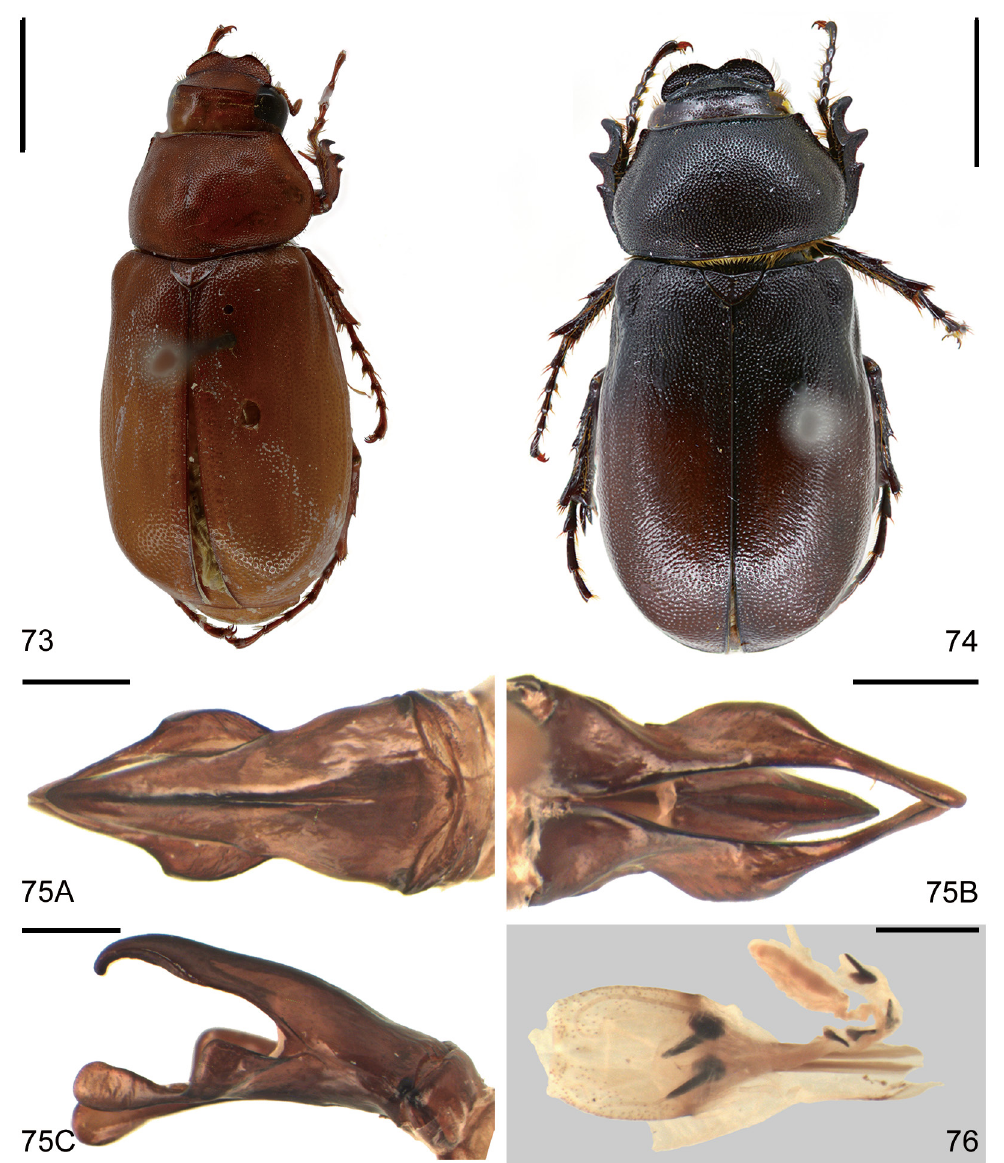
Figs 73–76. 73 . Miridiba behrensi Brenske, 1892, lectotype, ♂ (MFNB), habitus in dorsal view. 74– 76 . M. saigonensis (Moser, 1912), lectotype, ♂ (MFNB). 74 . Habitus in dorsal view. 75 . Parameres in dorsal (A), ventral (B) and lateral (C) views. 76 . Endophallus and temones in ventral view. Scale bars: 73–74 = 5.0 mm; 75–76 = 1.0